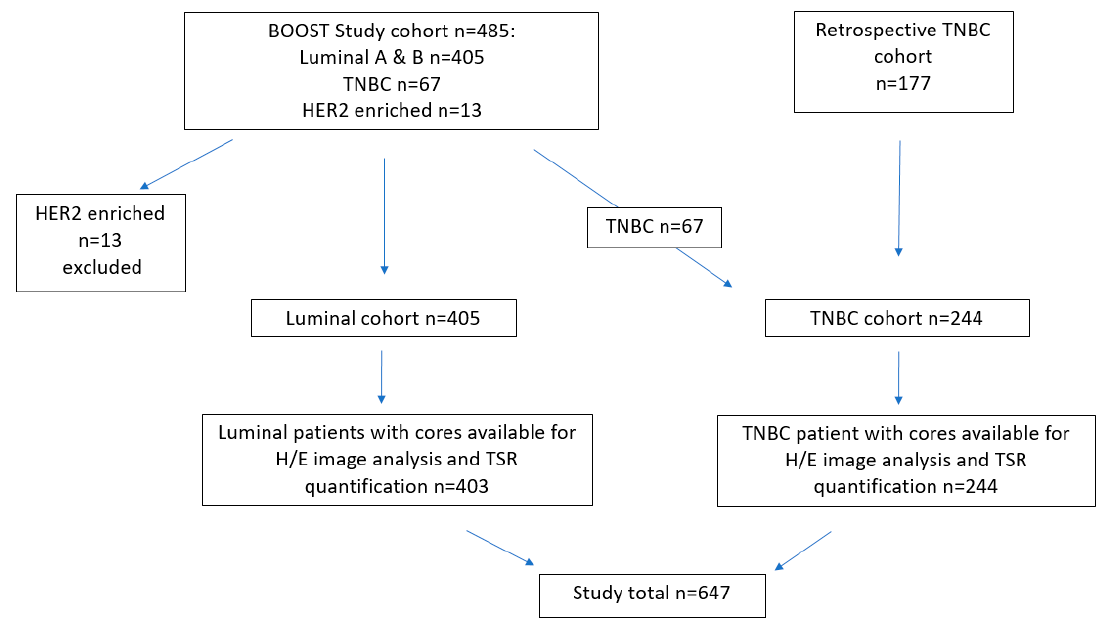
Figure 5. CONSORT flow diagram of the composition of the luminal and triple negative breast cancer (TNBC) samples used in the study.